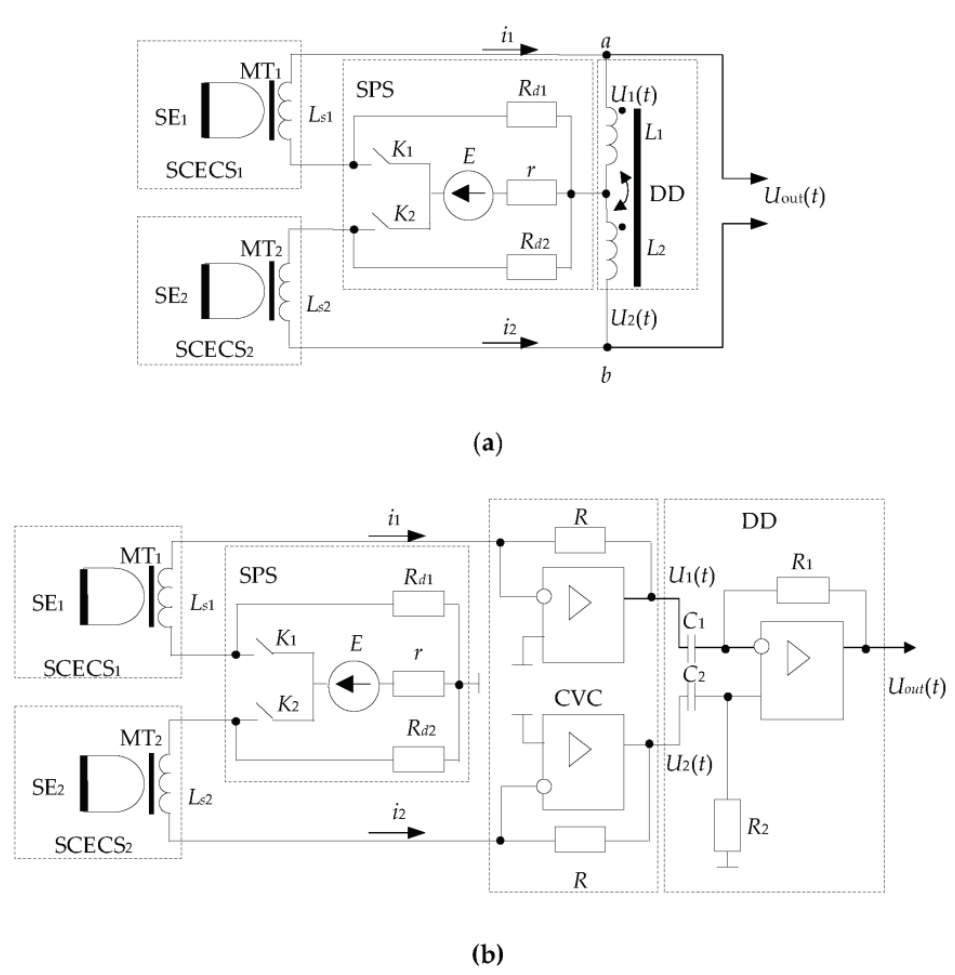
Figure 5. Measuring circuits with the differentiating devices on the base of Blumlein bridge ( a ) and operational amplifiers ( b ). operational amplifiers ( b